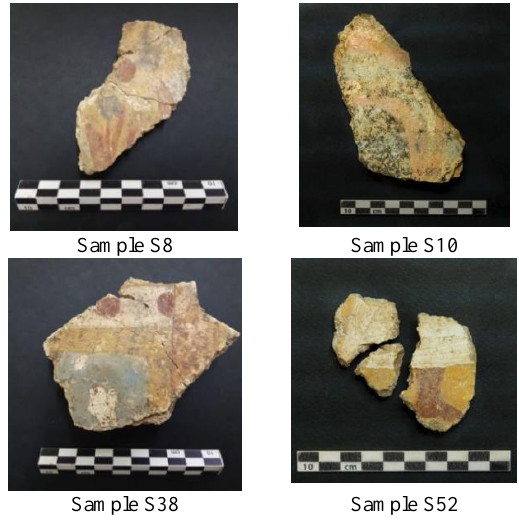
Figure 1The four samples used